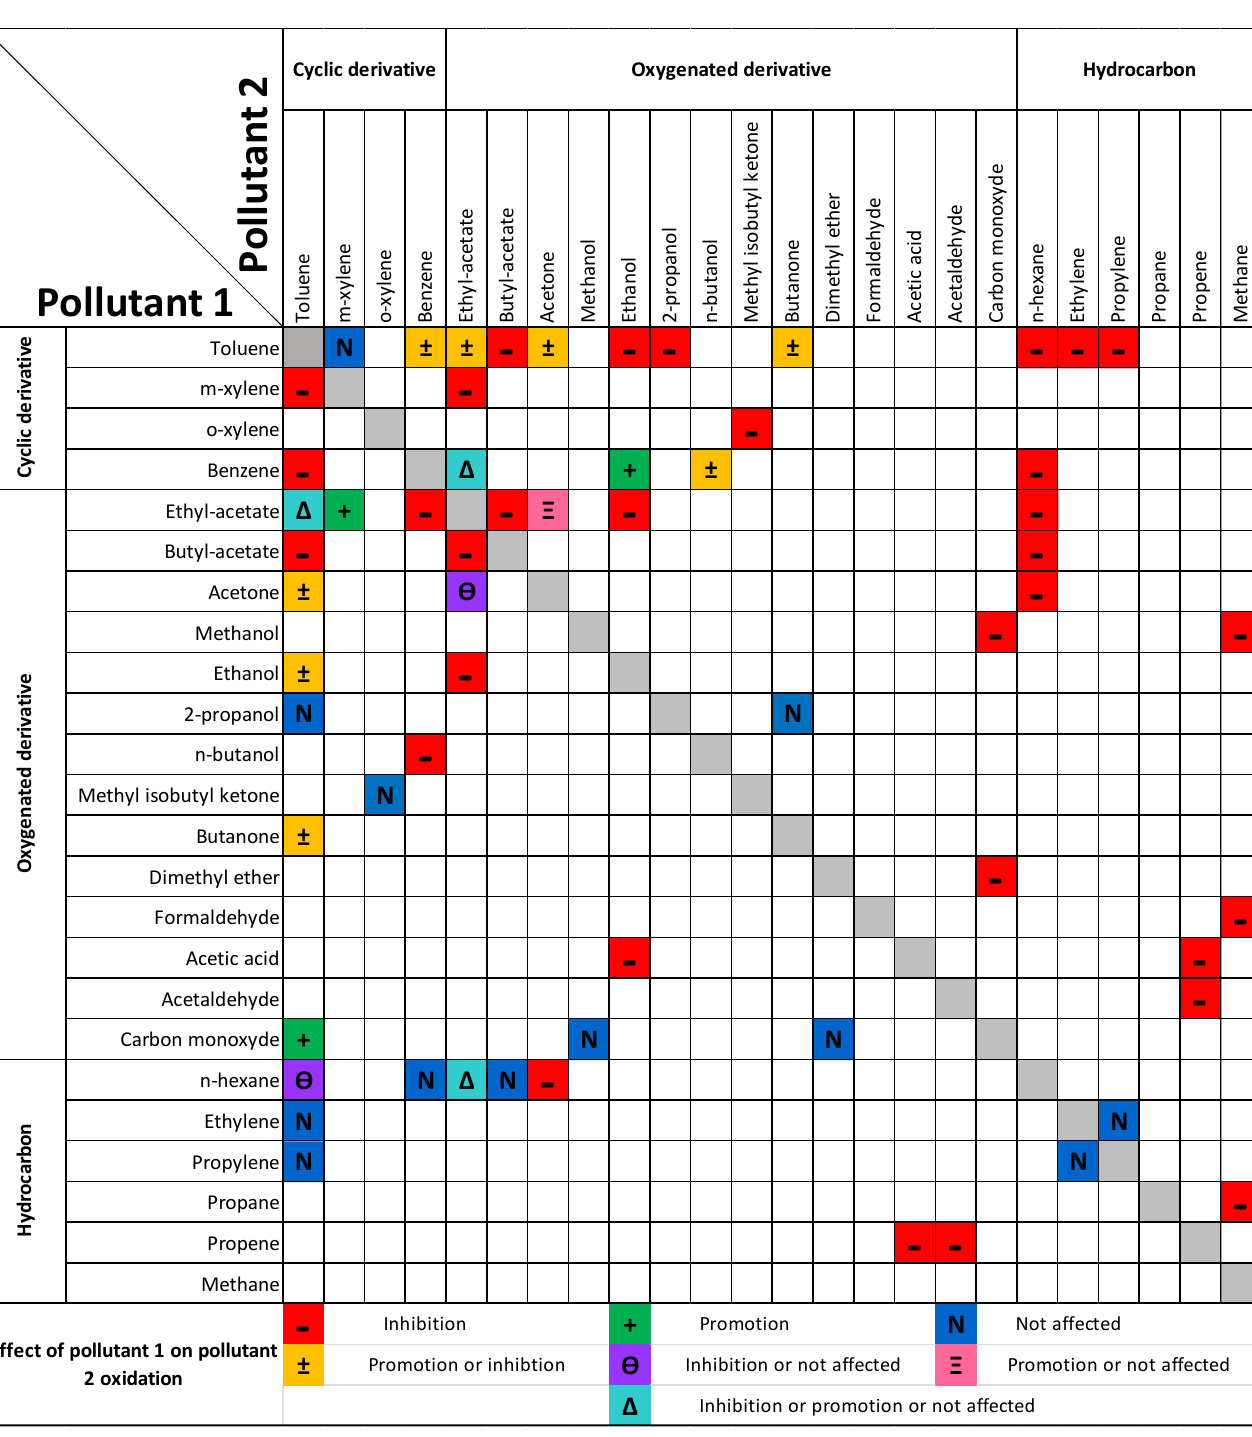
Figure 1. Summary of inhibition, promotion or no effects reported for oxidation reaction of VOCs mixture.